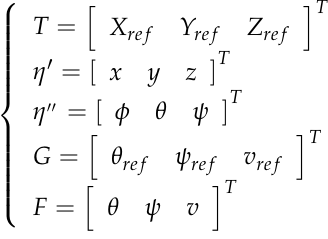
Figure 14. Block diagram of the proposed guidance and trajectory tracking with RLC.